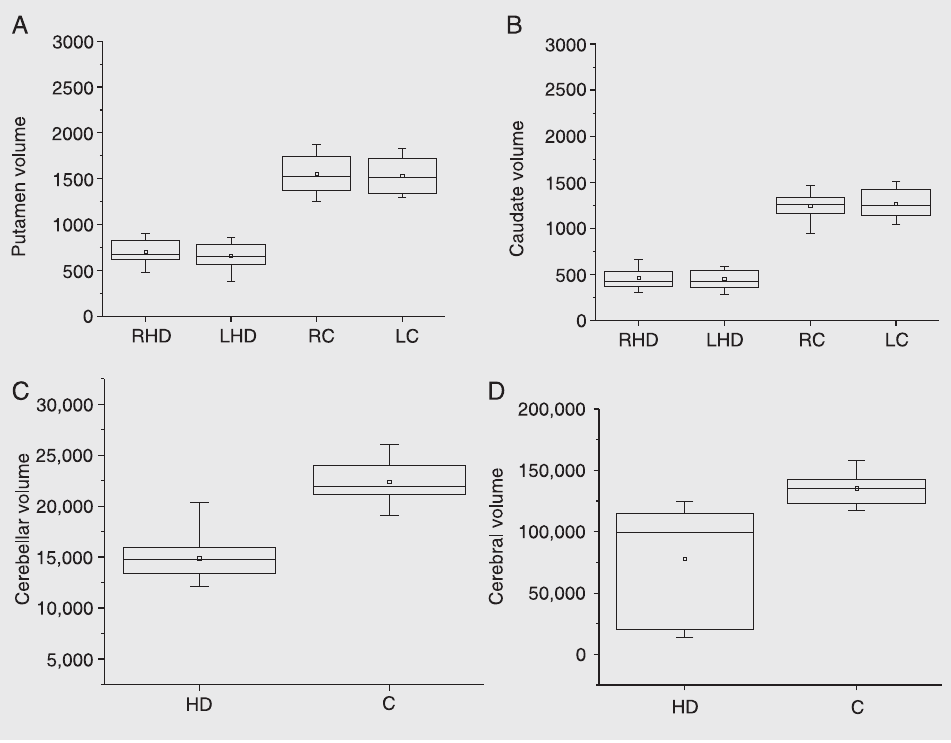
Figure 2. Box plot with putamen (A), caudate (B), cerebellar (C), and cerebral (D) volumes in 50 patients with Huntington’s dis- ease (HD) and 33 controls (C). The box extends from the 25th percentile to the 75th percentile, with a horizontal line at the me- dian (50th percentile). Whiskers extend down to the smallest value and up to the largest. RHD = right-sided volumes in patients with HD; LHD = left-sided vol- umes in patients with HD; RC = right-sided volumes in controls; LC = left-sided volumes in con- trols. There was a significant dif- ference between patients and controls for all comparisons (P < 0.0001; ANOVA for basal gan- glia and Mann-Whitney test for cerebellar and cerebral vol-